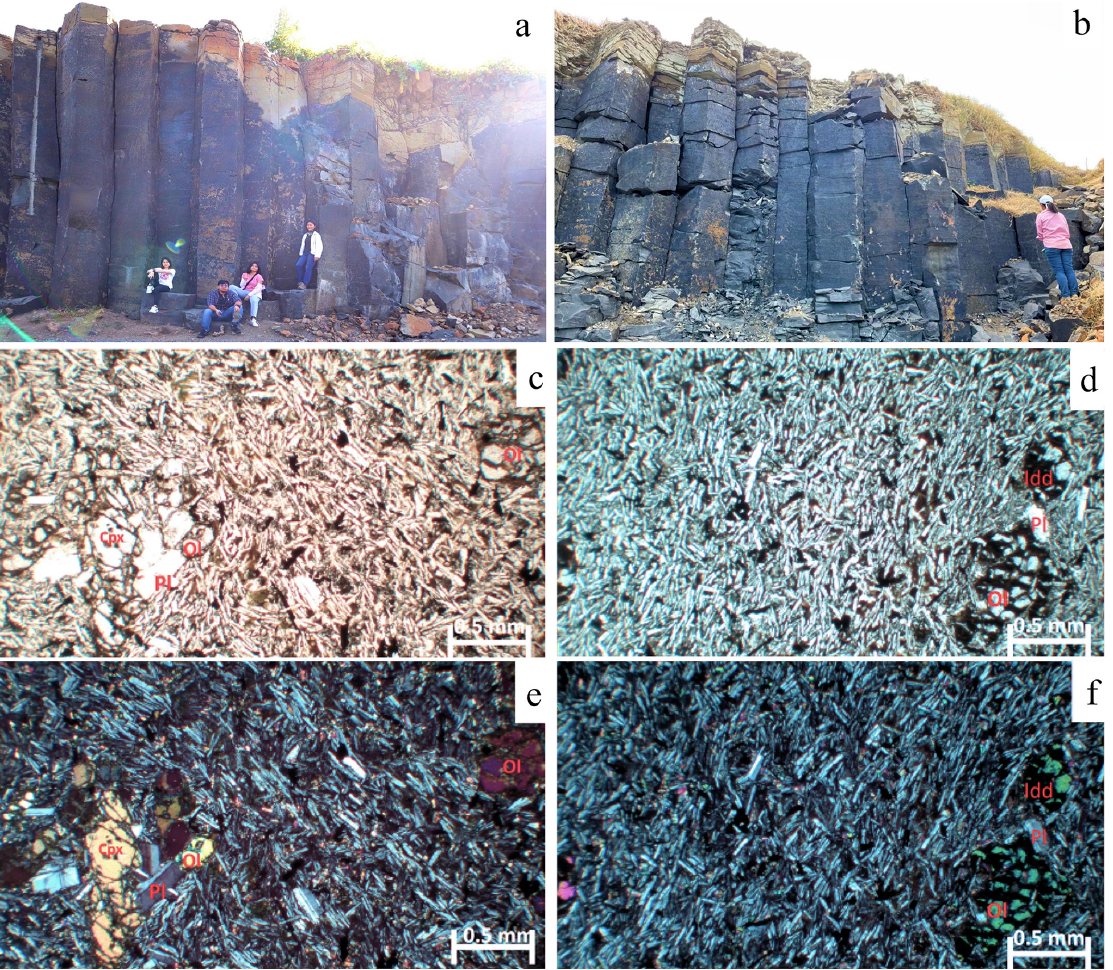
Fig. 3. Outcrop of Nang Rong Columnar Jointed Volcanics a – columnar joint, b – platy joint. The photomicrographs of olivine basalt showing porphyritic texture c – columnar basalt in Nang Rong Columnar Jointed Volcanics in plane-polarized light, e – crossed polarized light, d – platy basalt in Nang Rong Columnar Jointed Volcanics in plane-polarized light, f – crossed polarized light. Ol, olivine; Cpx, clinopyroxene; Pl, plagioclase; Idd,